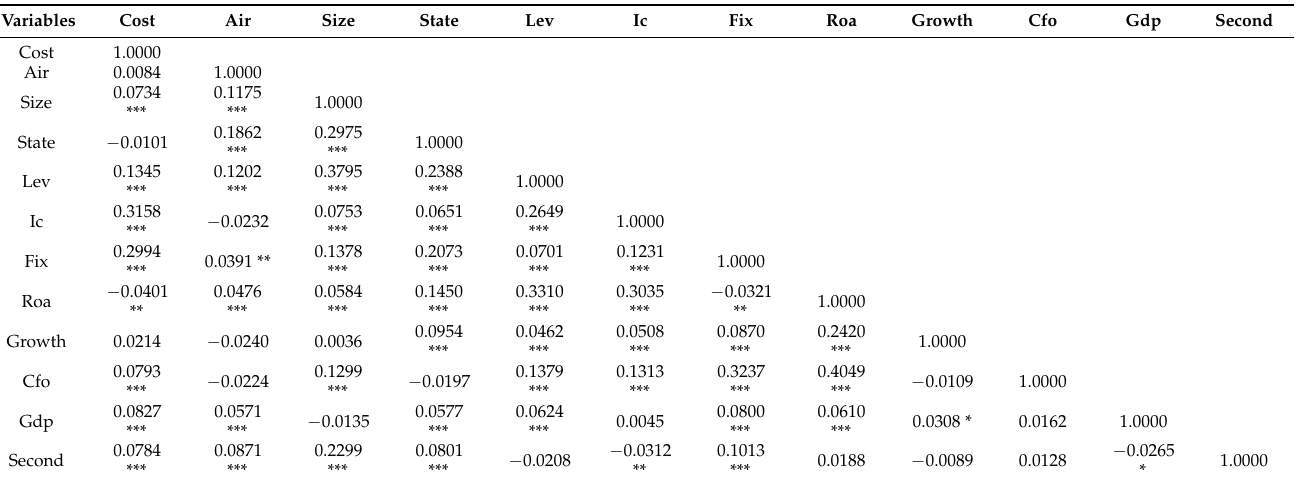
Table 5. Pearson